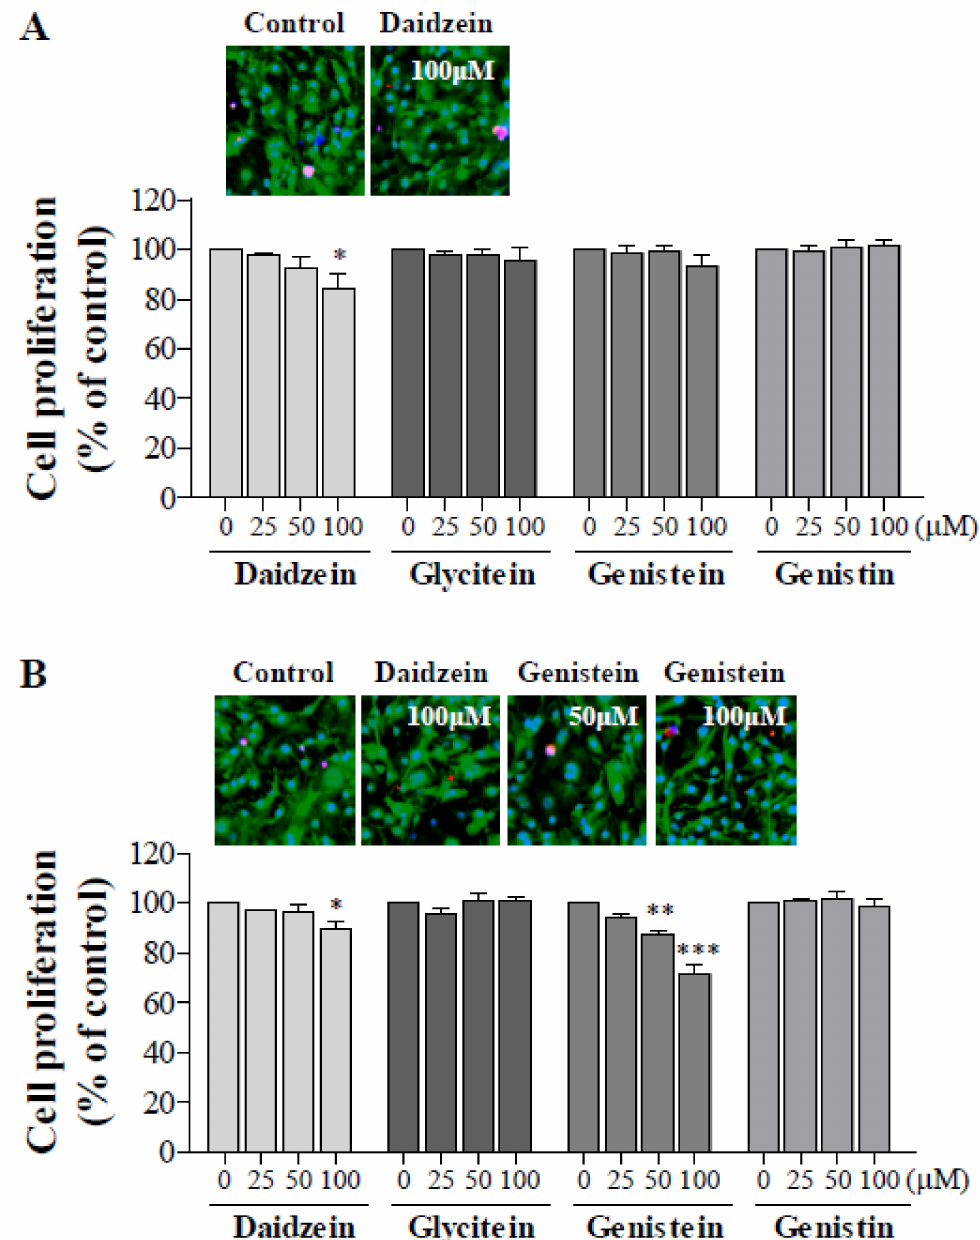
Figure 1. E ff ects of soy isoflavones on 3T3-L1 cell proliferation. 3T3-L1 preadipocytes were treated with 25, 50, and 100 µ M daidzein, glycitein, genistein, and genistin for ( A ) 24 h and ( B ) 48 h, and cell proliferation was measured using CCK-8 assays. All data are presented as the mean ± SD and analyzed with one-way ANOVA and compared with those from the isoflavone-untreated control ( n = 3, * p < 0.05, ** p < 0.005, *** p < 0.001). Live / dead cells were imaged to confirm the cytotoxicity of each compound. Green: live; red: dead; blue: